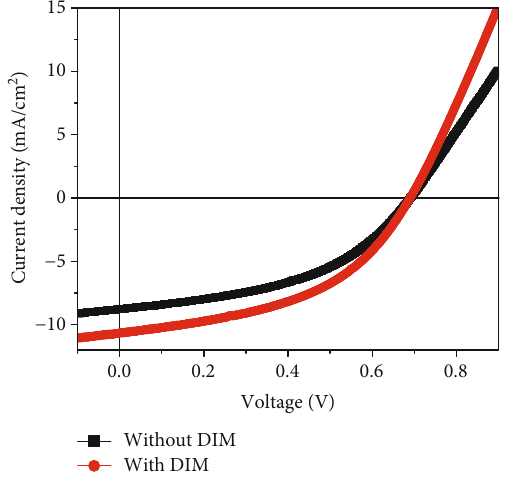
Figure 3: Current-voltage characteristics of PCDTBT:PC solar cells processed without and with 3%